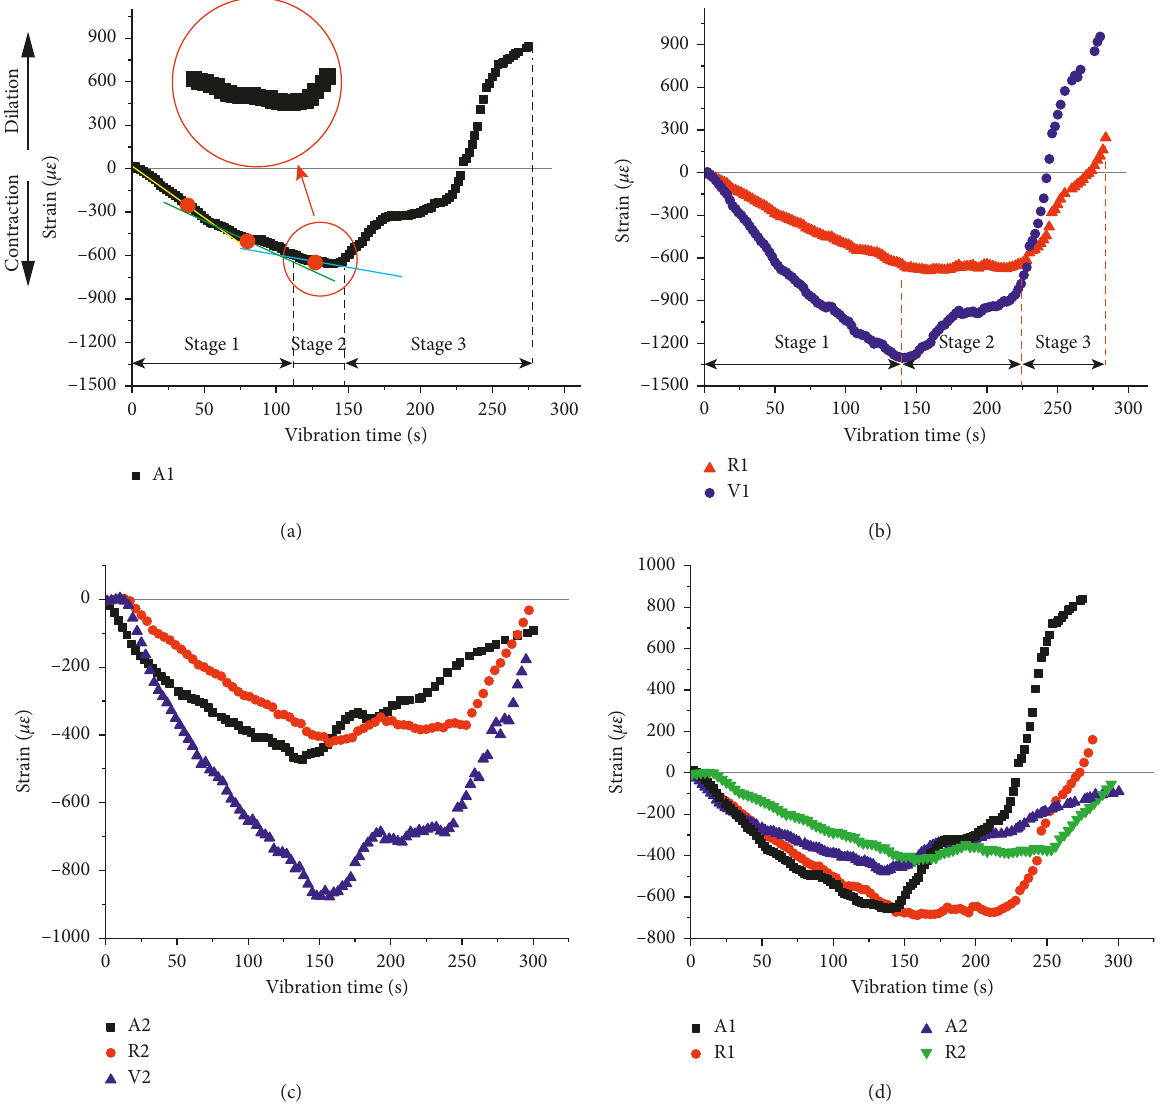
Figure 5: Strain data in the continuous vibration strain test. (a) Axial strain at H1. (b) Radial and volumetric strain at H1. (c) Axial, radial, and volumetric strain at H2. (d) Axial and radial strain at H1 and